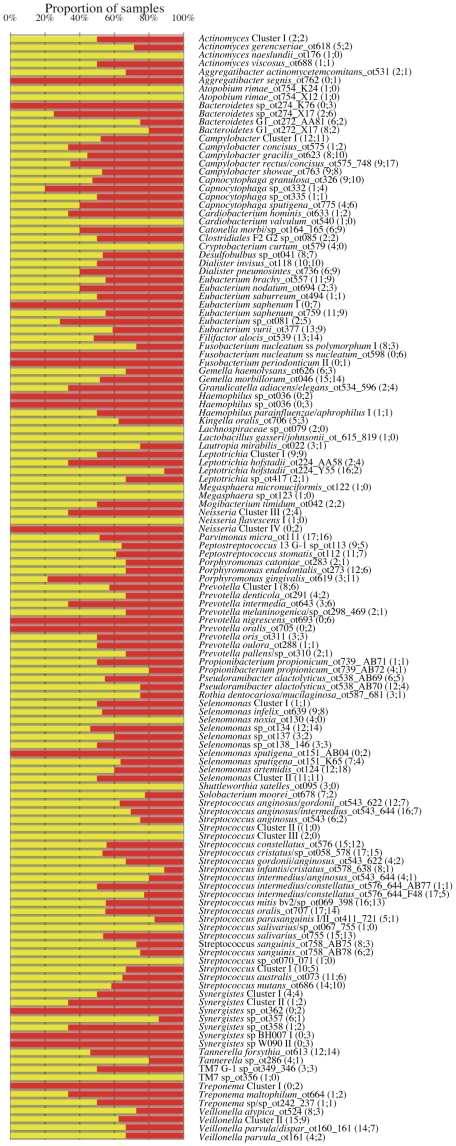
Distribution pattern for species/phylotypes in GCF samples and subgingival PP samples.The bars show proportion of GCF and PP samples of all samples testing positive for the depicted species/phylotypes. The numbers in parentheses after species definitions show the number of positive samples in both types of samples (PP;GCF). Yellow bars PP samples, red bars GCF samples. PP: paper point; GCF: gingival crevicular fluid.